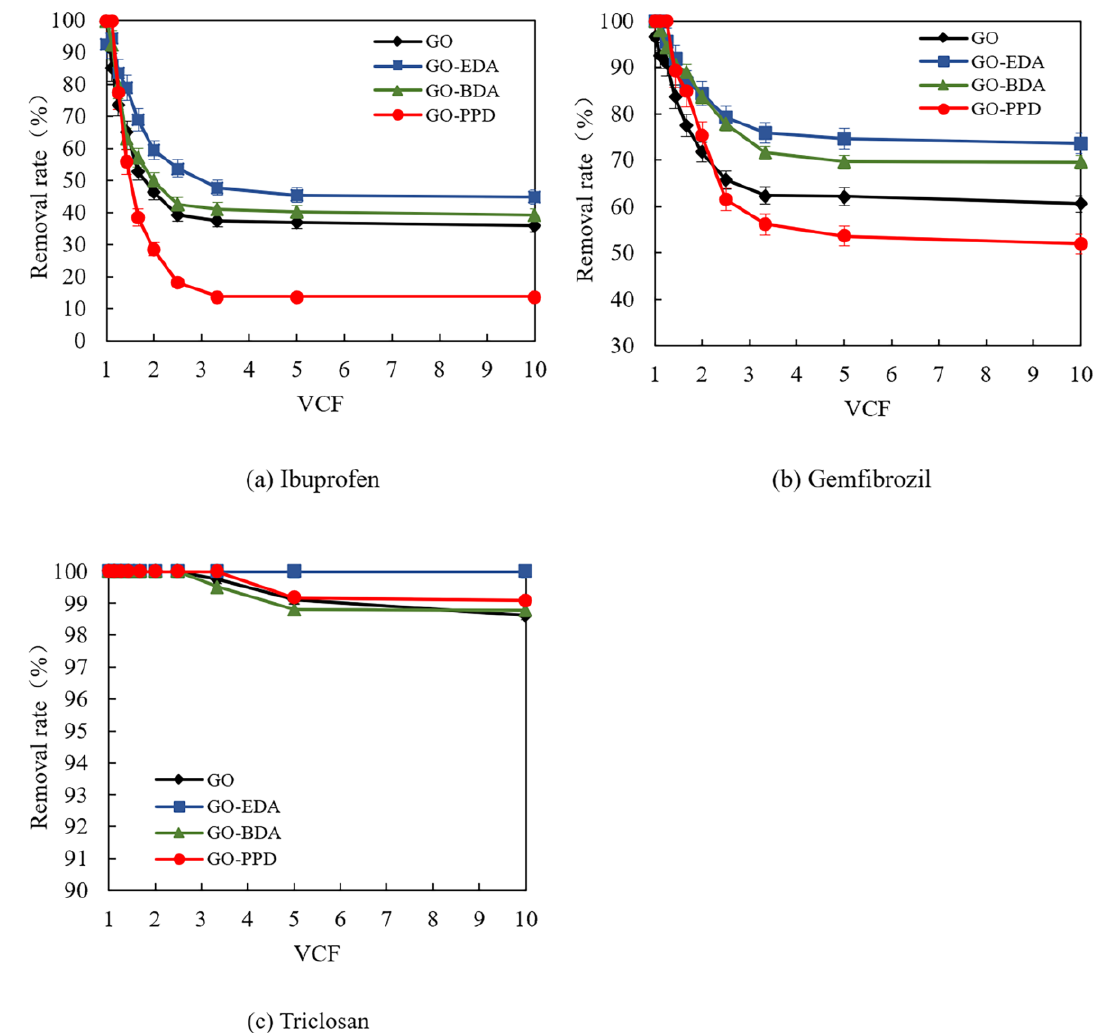
Figure 7. The removal rate of PPCPs: ( a ) ibuprofen, ( b ) gemfibrozil, and ( c ) triclosan by cross-linked GO membrane at pH 3.